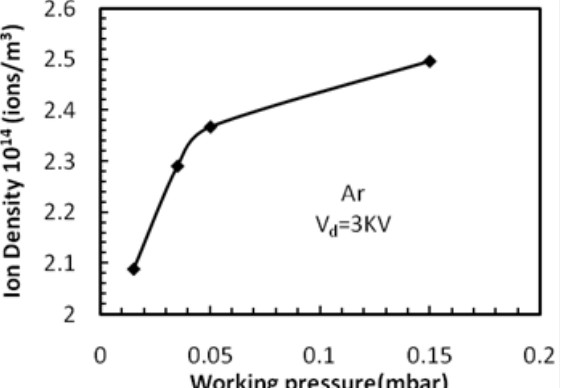
Fig. 8: The Ion density of Ar plasma measured as function of working